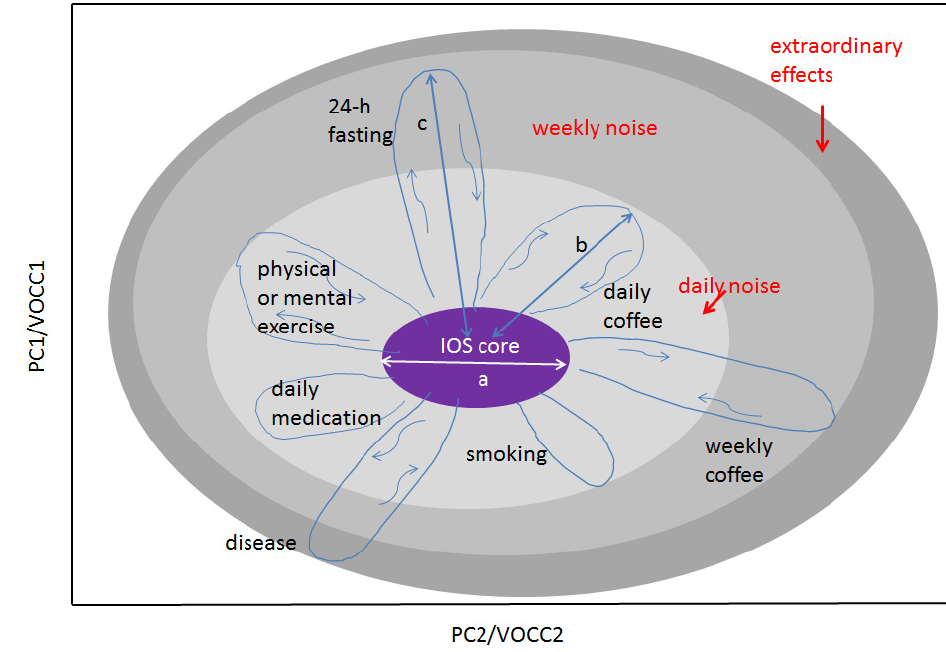
Figure 6. An illustration of the IOS concept for an individual. Any physiological parameters of the body can be presented on this graph. The space of representation can be blind (PC, canonical analysis) or show measurable variables such as VOC concentrations (VOCC) as its axes. Shown: the light grey area represents several daily factors affecting the IOS core and increasing thus the measurable IOS size; the medium grey area, factors affecting IOS on a weekly or monthly scale such as fasting or coffee intake for rare coffee drinkers; the dark grey area, extraordinary effects such as strong stress or disease. There are two main scales making the concept quantifiable: the core size a and the strength of the effect b, c, etc. In the case of VOCC representation, scale parameters a and b are reduced to n and δ n. The concept can be extended to many individuals. In this case, two other scales should be used: a and l, where l is the distance between the IOS cores. The higher the space dimensionality, the more cross sections can be found where any two persons will have l > a. (Ref.[17]).